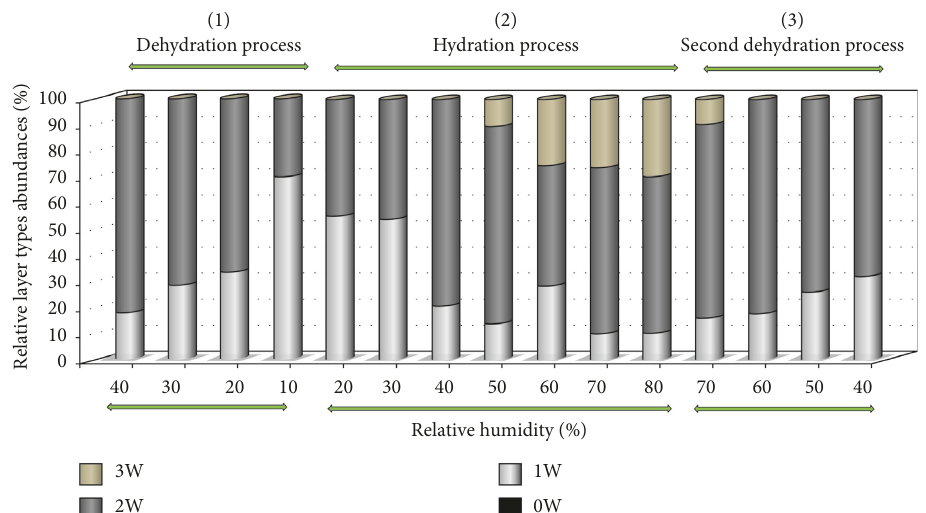
Figure 6: Evolution of the relative contribution of the different layer types (summing up all MLSs) as function of the RH% in the case of the second